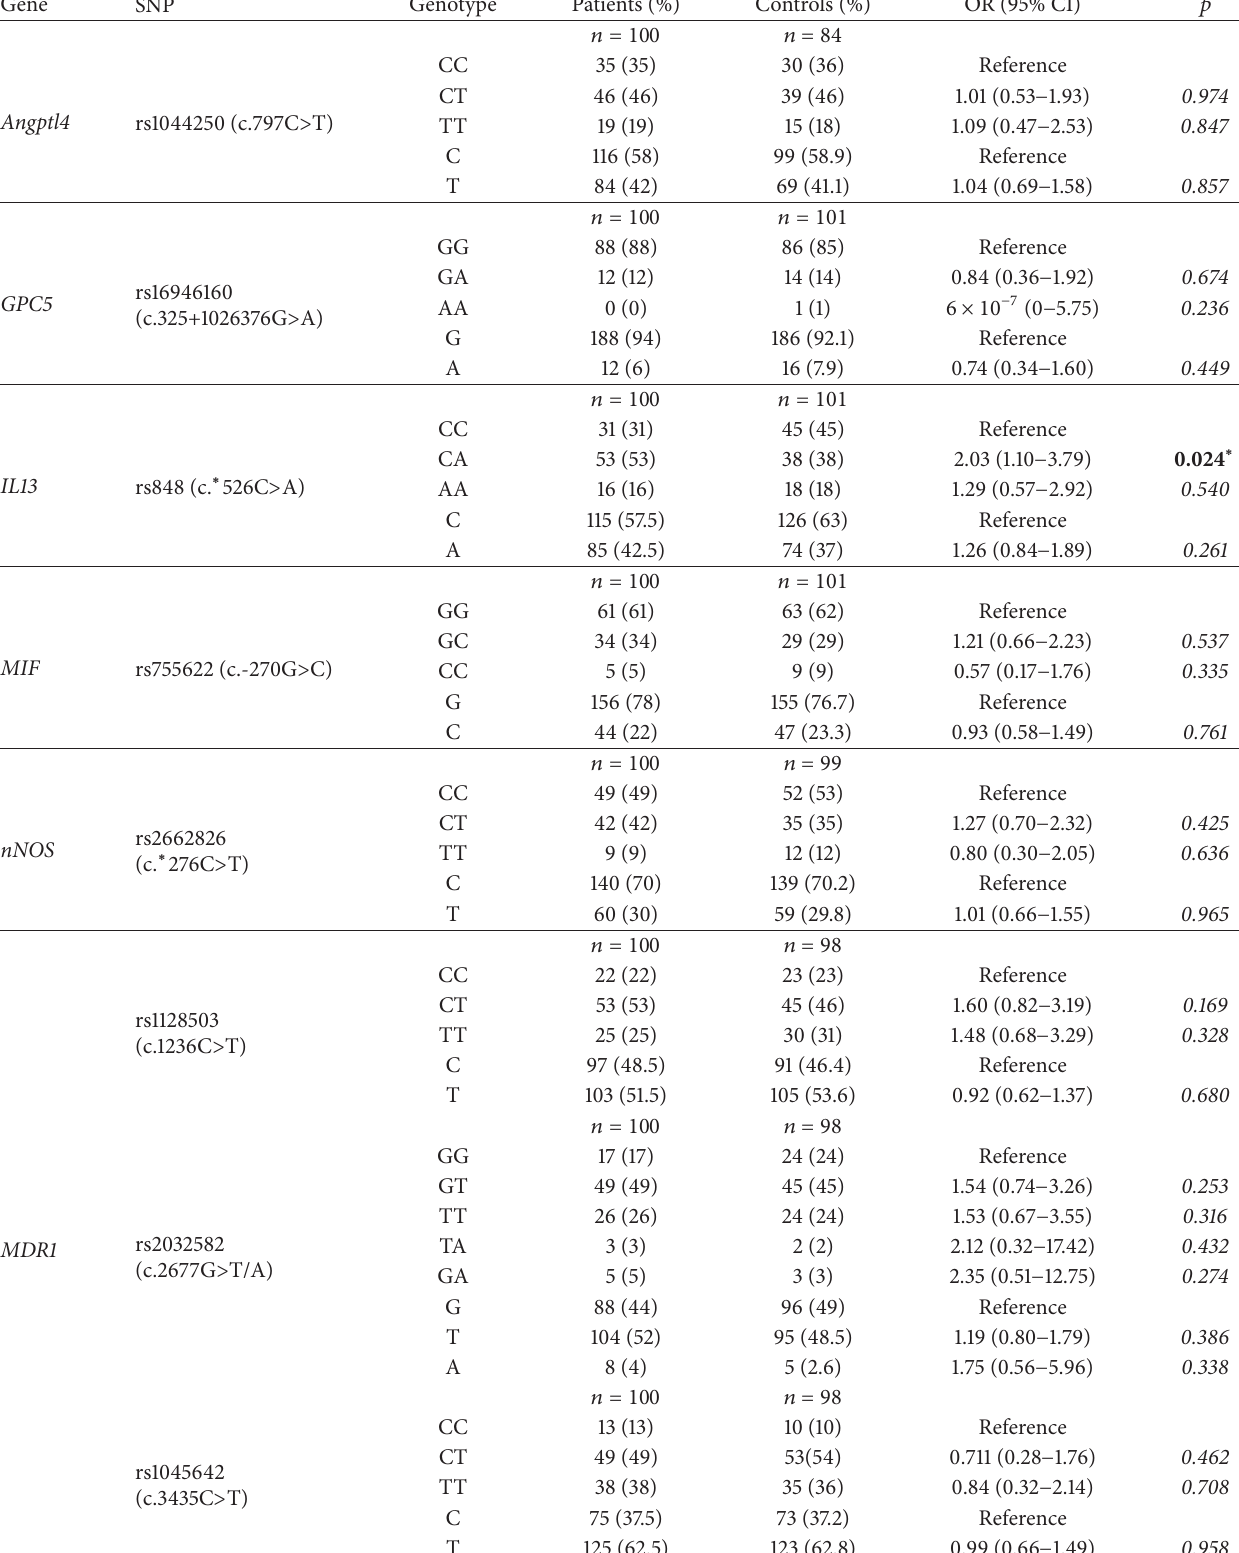
Table 3: Comparison of patient and control genotype distribution. OR, odds ratio. CI, confidence interval. 𝑝 values lower than 0.05 are marked with ∗